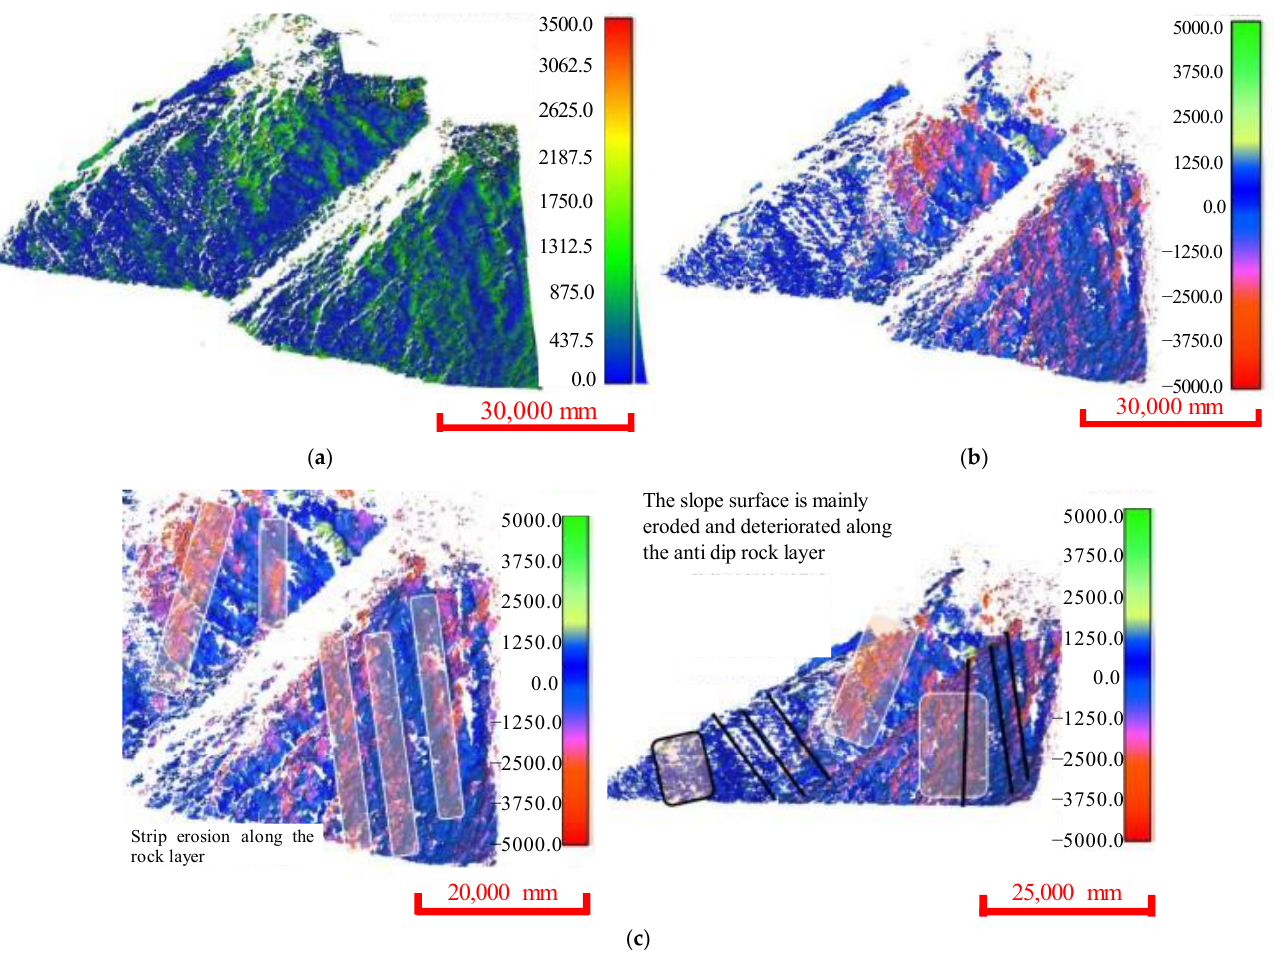
Figure 13. The 3D deformation of a large-scale Yangjiaping bank slope. ( a ) Deformation distribution of the measured area after C2C analysis. ( b ) Deformation distribution of the measured area after M3C2 analysis. ( c ) Details of slope deformation.